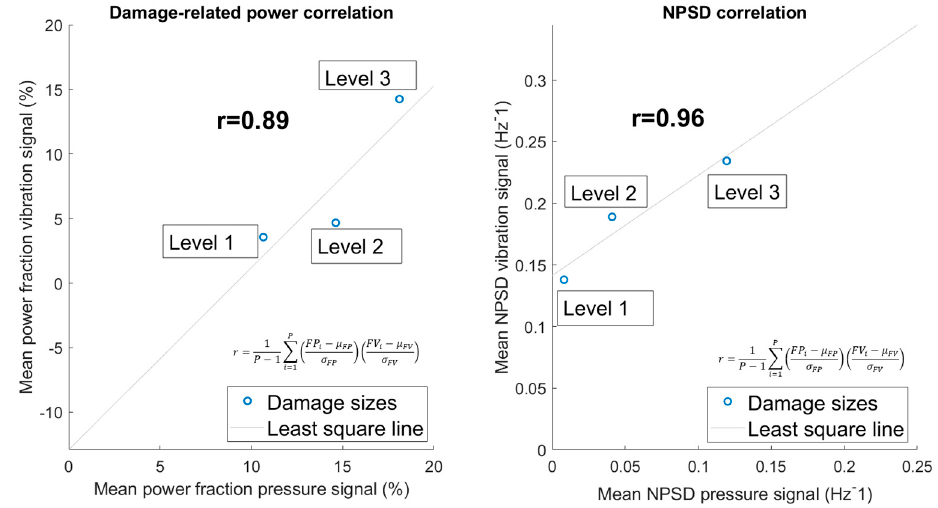
Figure 23. Correlation between the pressure and vibration signals by means of HI and NPSD.